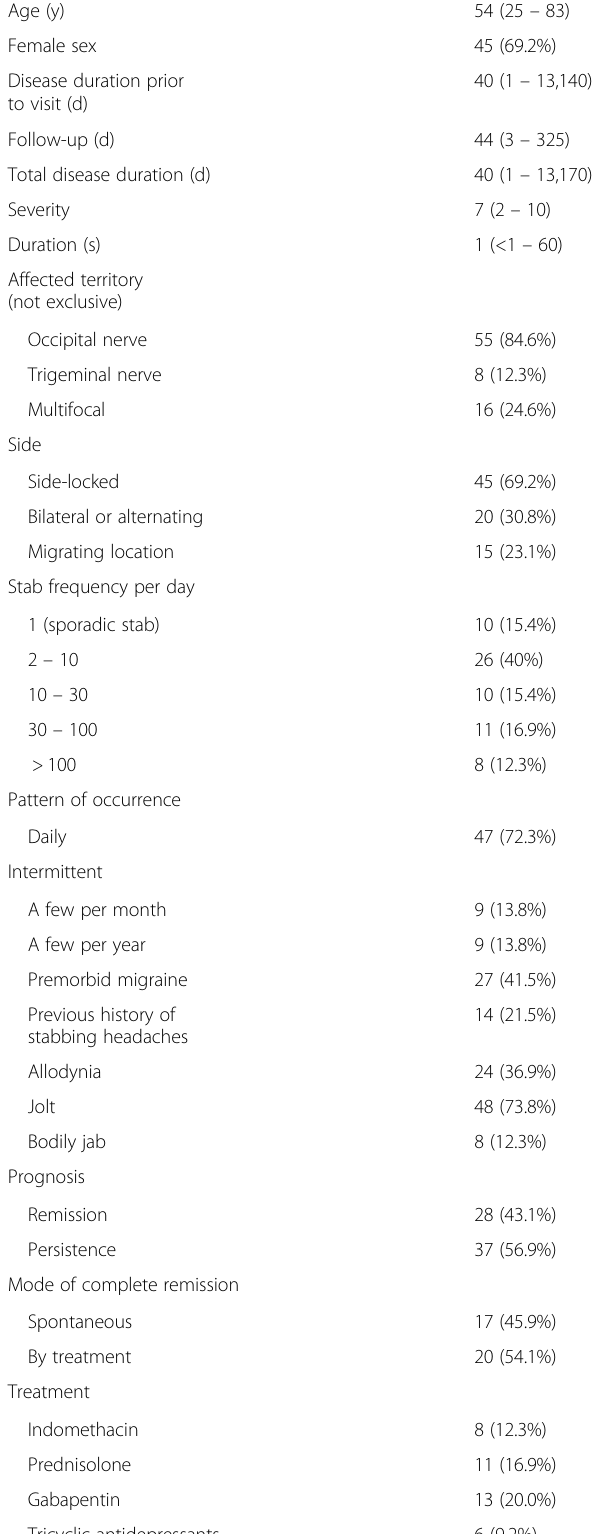
Table 1 Patient